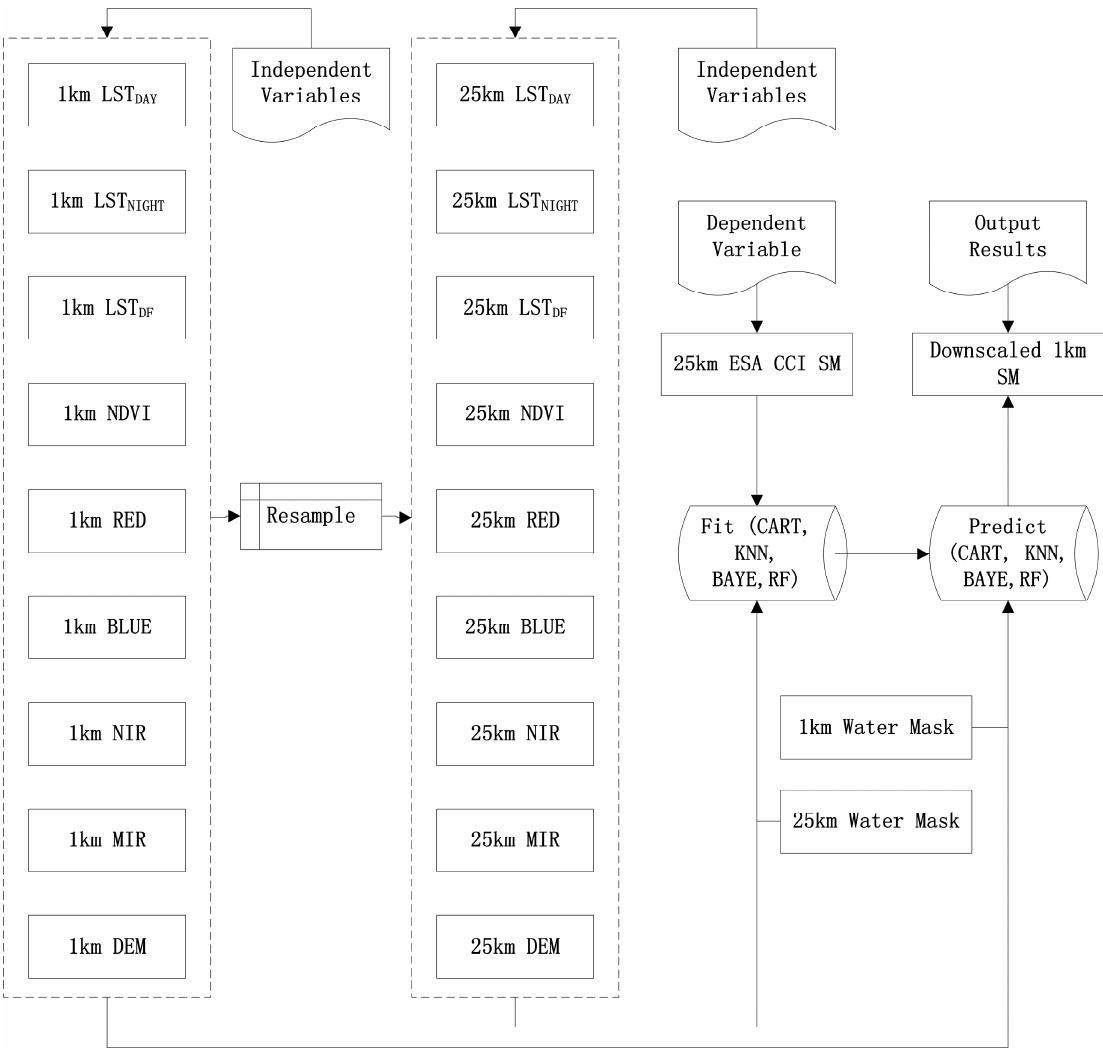
Figure 2. Specific procedures of relevant data processing and ESA CCI SM downscaling.